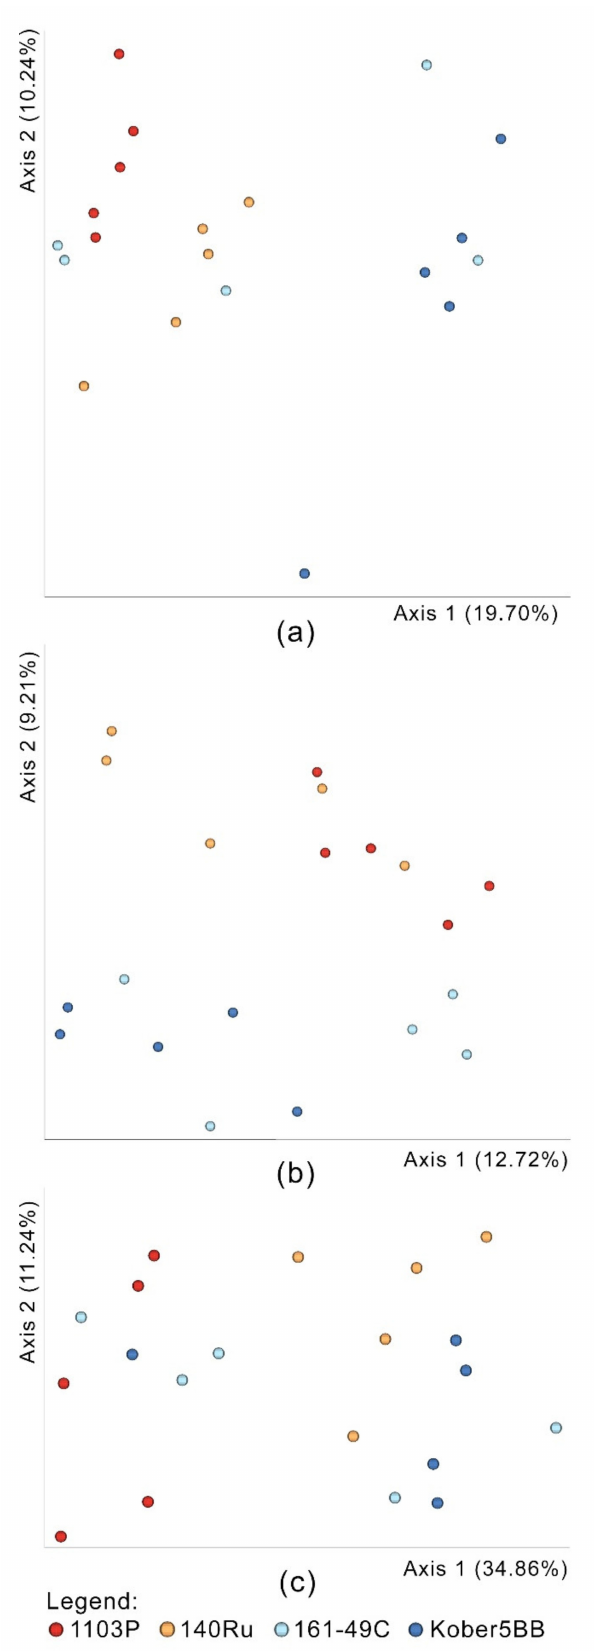
Figure 3. Principal Coordinate Analyses (PCoAs) reporting the distance matrices of the beta diversity indexes: ( a ) Bray-Curtis, ( b ) unweighted UniFrac and ( c ) weighted